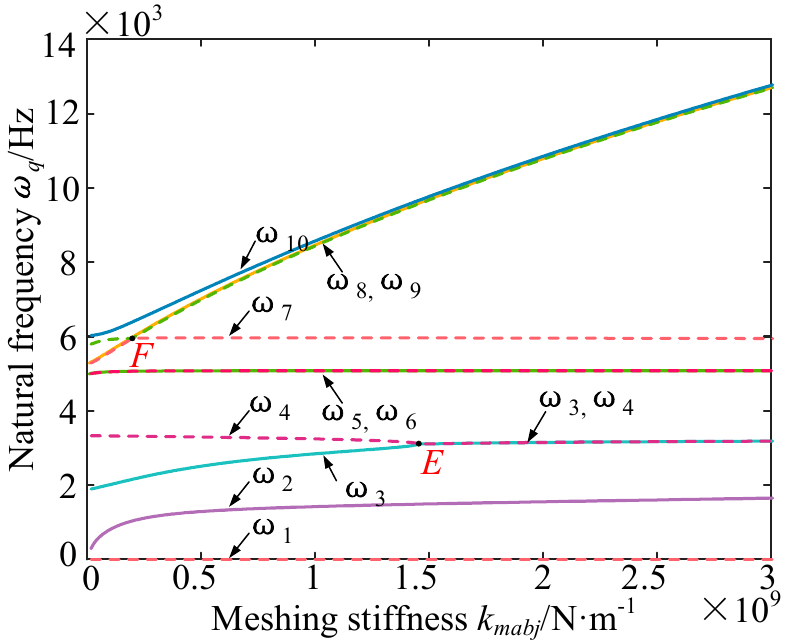
. (cid:3040)(cid:3045)(cid:3029)(cid:3037)